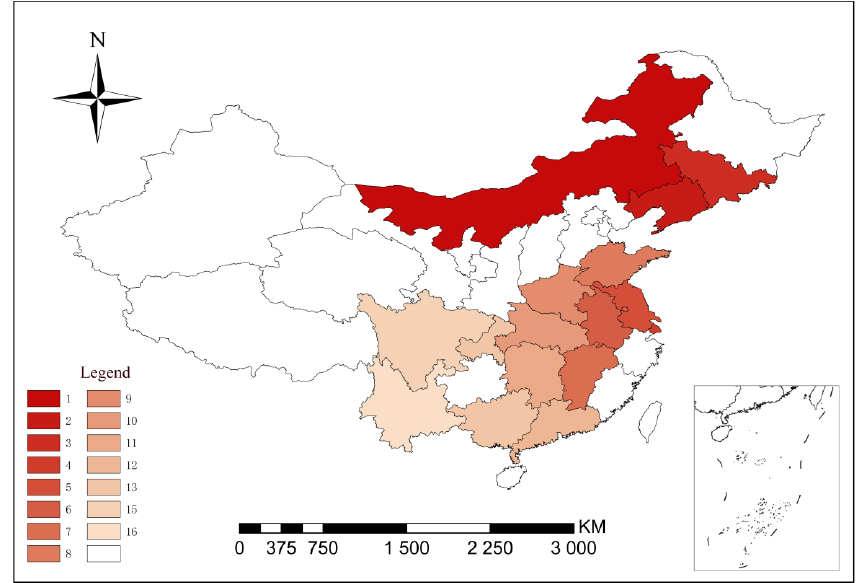
Figure 7. Visual analysis of the drug resistance index (DRI) using doxycycline as an example.